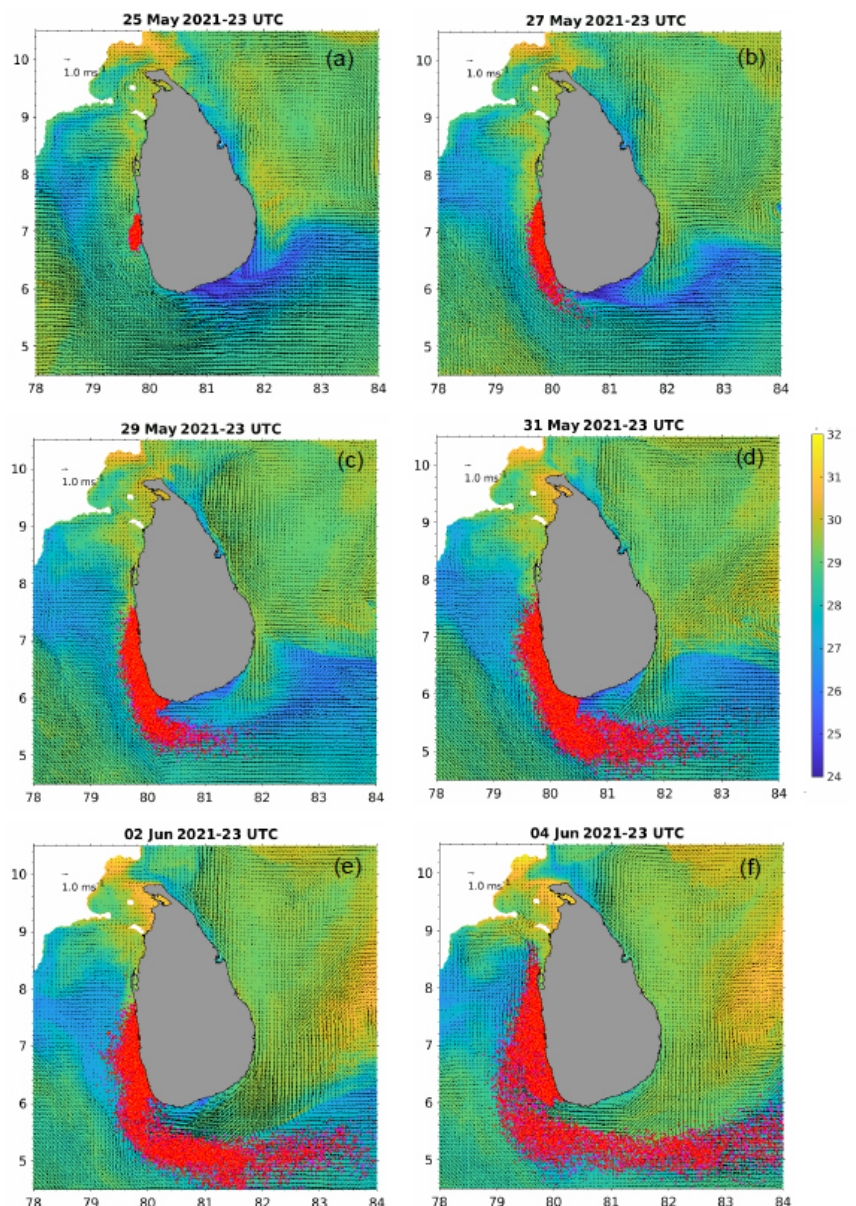
Figure 9. Time series of the simulated pathway of nurdles from 25 May to 4 June 2021 at 48h intervals. The nurdles are shown as red dots, colours are sea surface temperature ( ◦ C), and arrows represent surface velocity